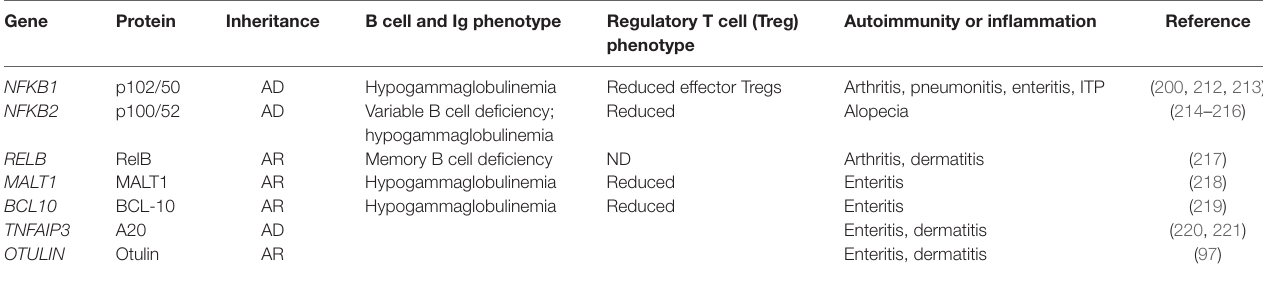
TABLe 2 | Mendelian defects in NF- κ B pathway genes that confer syndromes including autoimmune manifestations. Gene Protein